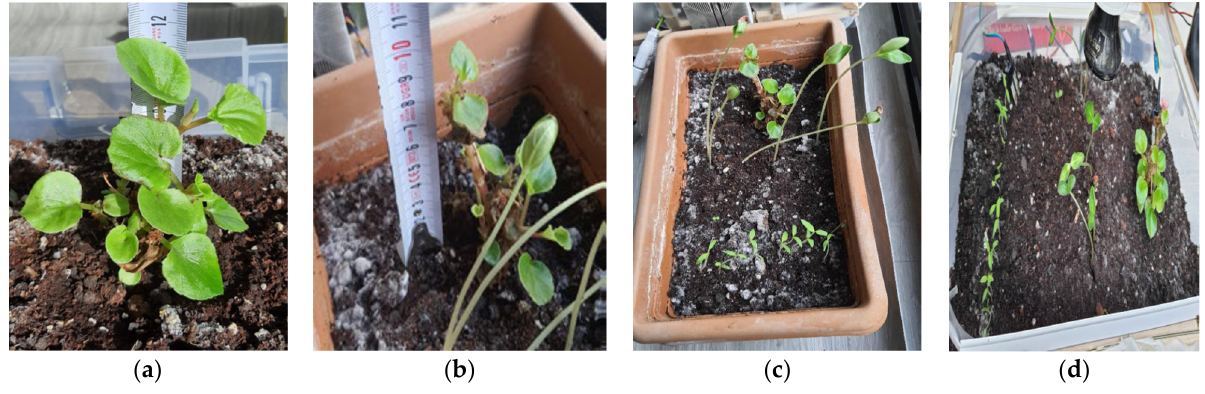
Figure 17. Final status of the begonia flower ( a ) in the smart greenhouse ( b ) in the pot and the sun- related changes of plants ( c ) in the pot and ( d ) in the smart greenhouse.